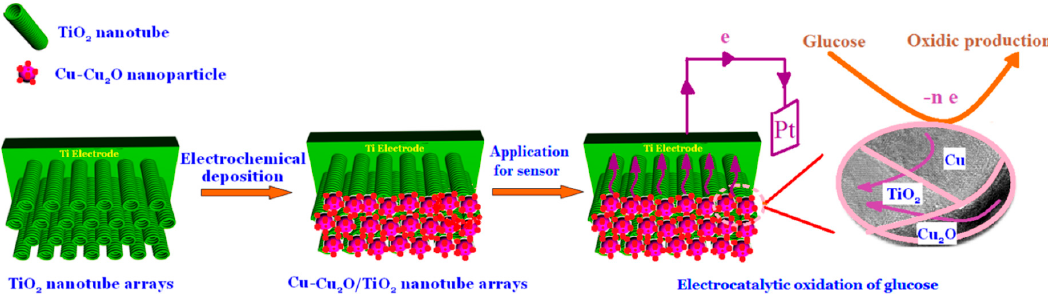
Figure 9. A schematic illustration of the preparation of the Cu − Cu 2 O/TiO 2 nanotube array/Ti electrode and the electron transfer through the Cu − Cu 2 O/TiO 2 nanotube array interface for the electrocatalytic oxidation of glucose Image reproduced from [78]. Copyright (2015) American Chemical Society.